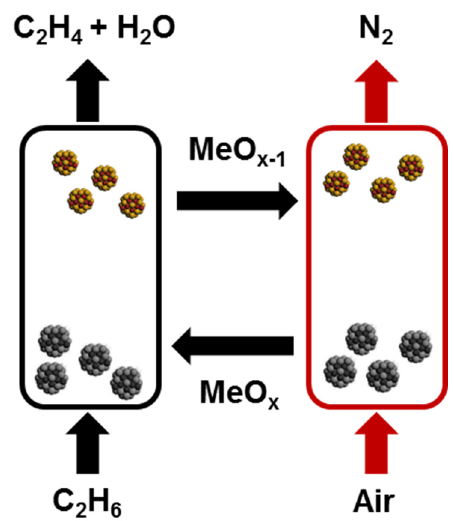
Figure 3. Schematic of the chemical looping process.